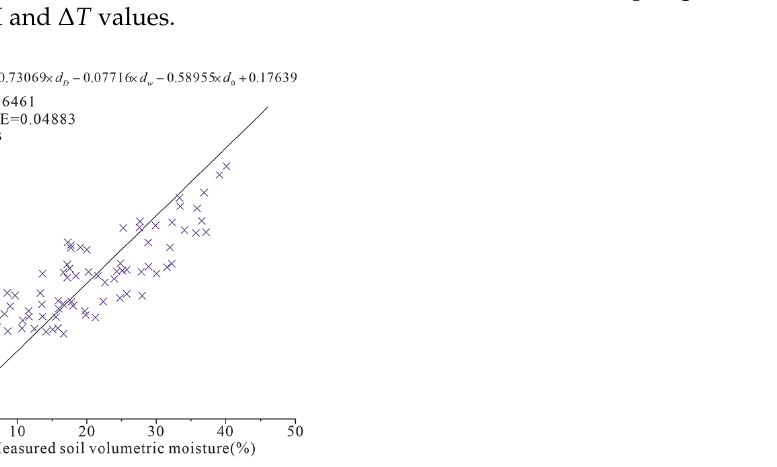
Figure 10. The scatter plot between measured and estimated soil relative moisture at the Naqu test site. A 1:1 line is added in the plot. Table 3. The collection between measured and estimated SM in four groups with respect to the NDVI values.